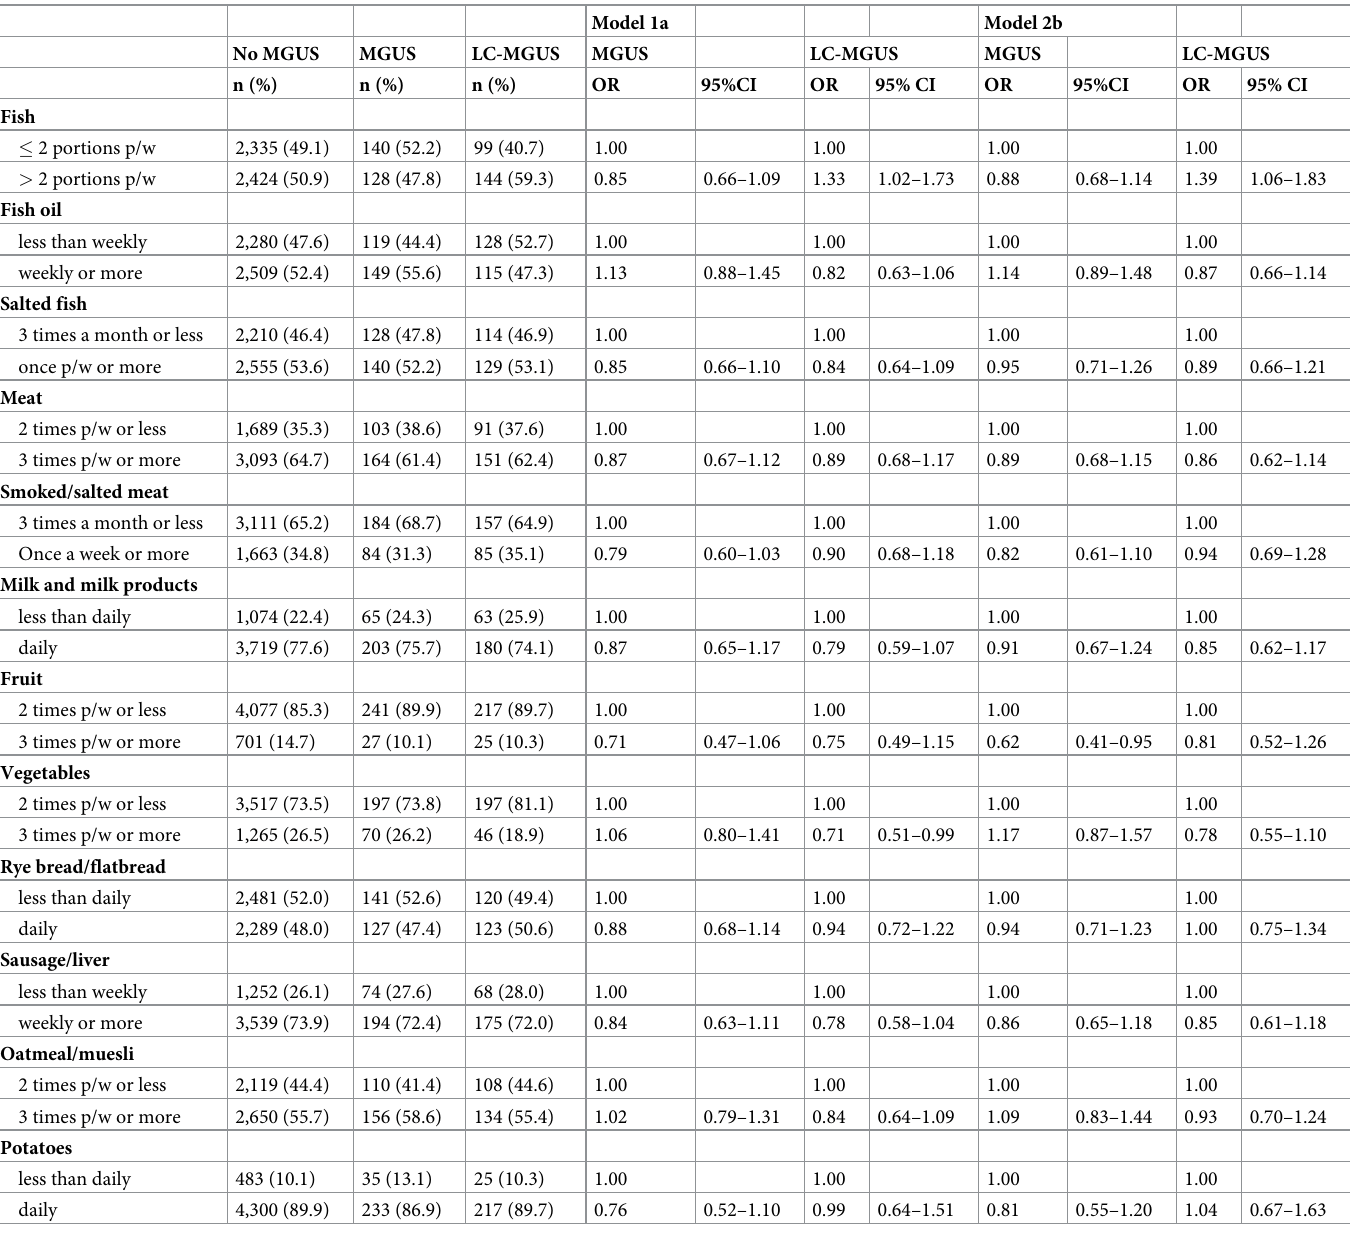
Table 2. The association between diet in adolescence and MGUS and